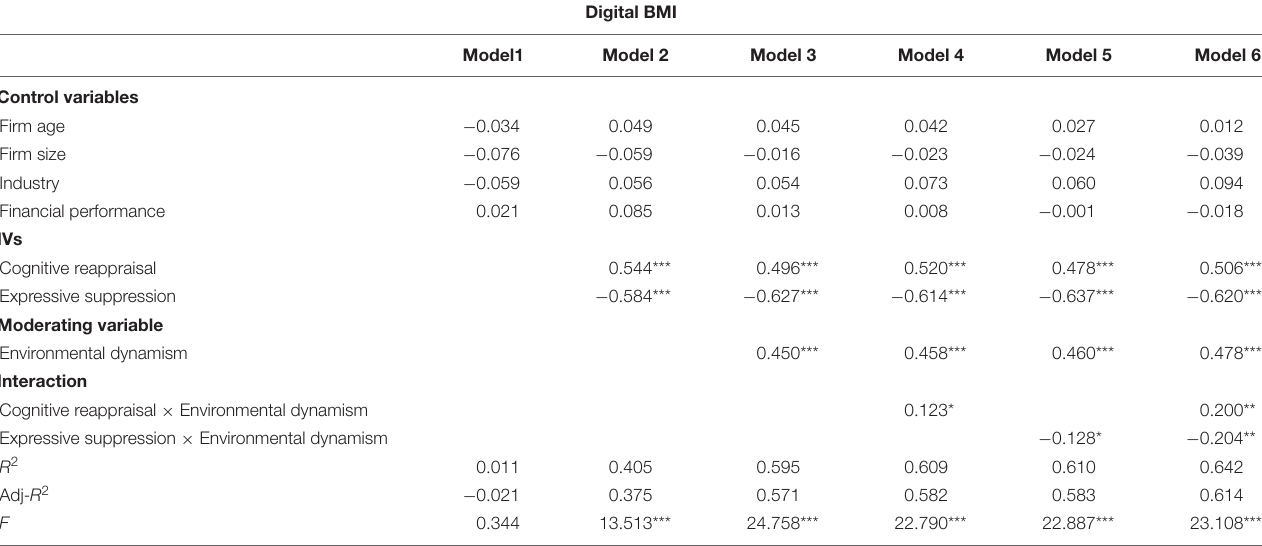
TABLE 3 | Regression models of emotion regulation and digital BMI.